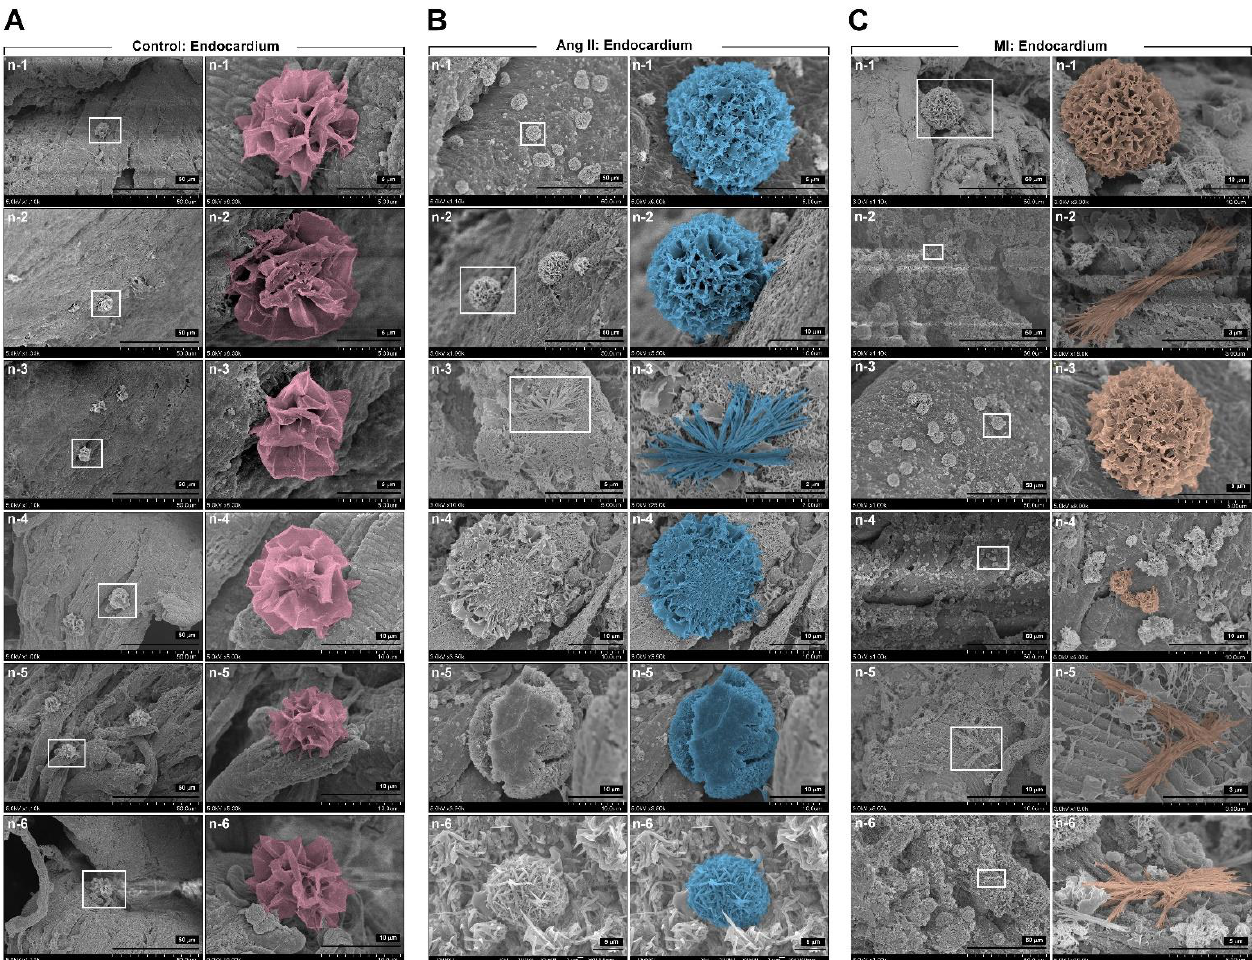
Figure 3. Scanning electron microscopy images of mineral deposition in Ang II- and ischemia heart-induced HF model. ( A ) Control group endocardium. ( B ) Ang II group endocardium. ( C ) LAD ligation-induced MI group endocardium.